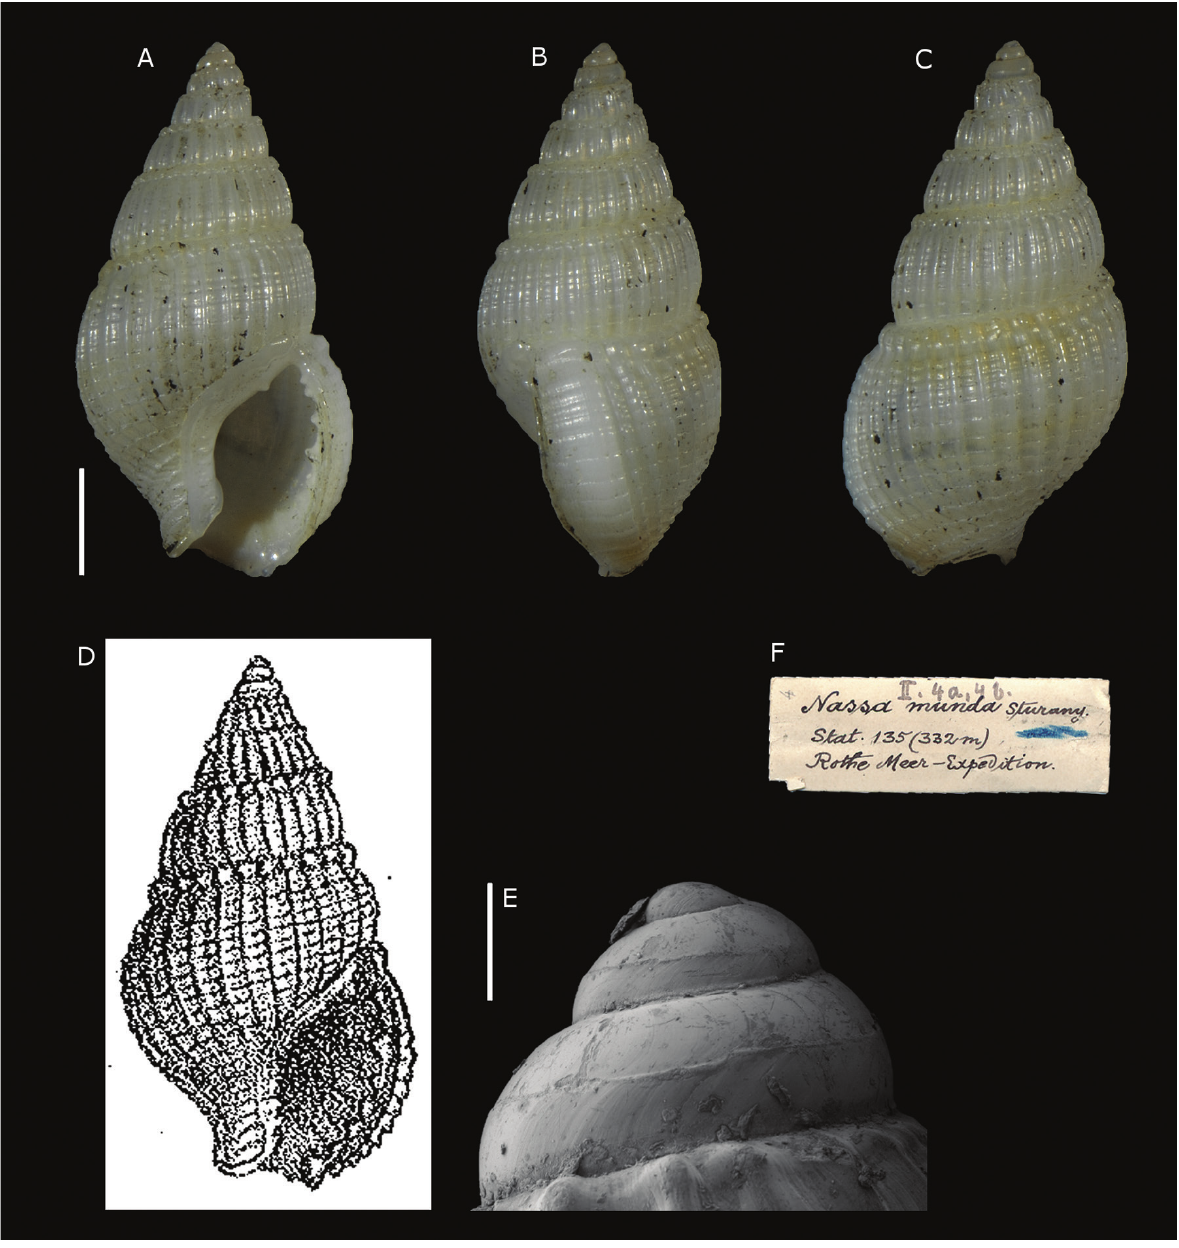
Figure 13. Nassa munda Sturany, 1900, Station 135 (Akik Seghir, Eritrea, Red Sea). A–C, E . Figured syntype, NHMW 84190: front ( A ), right side ( B ), back ( C ), protoconch ( E ). D . Original figure by Sturany (1903). F . Original label of figured syntype. Scale bars: A–C : 2 mm, E : 0.2 mm.